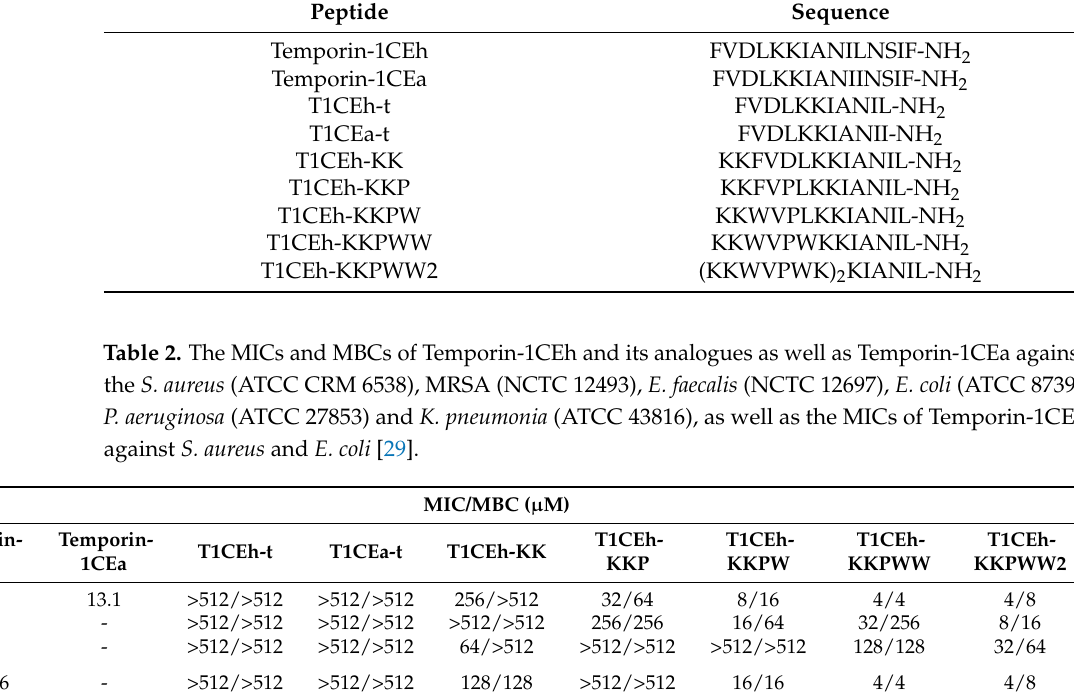
Table 1. Peptide sequences of parent peptide Temporin-1CEh and its analogues. Peptide Sequence Temporin-1CEh